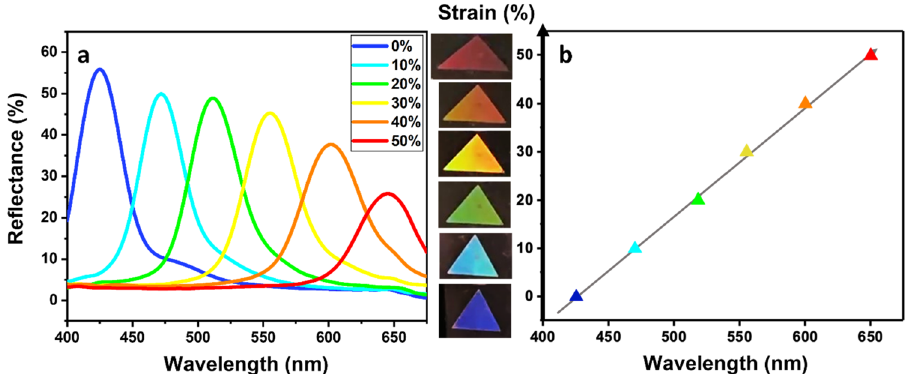
Figure 7. Strain-responsive characteristics of the sensor substrate which was made from 780 nm nanoparticles. ( a ) Reflectance spectra for various strain. ( b ) Colors and diffracted wavelengths for various strain and their comparison with theorical calculation (gray